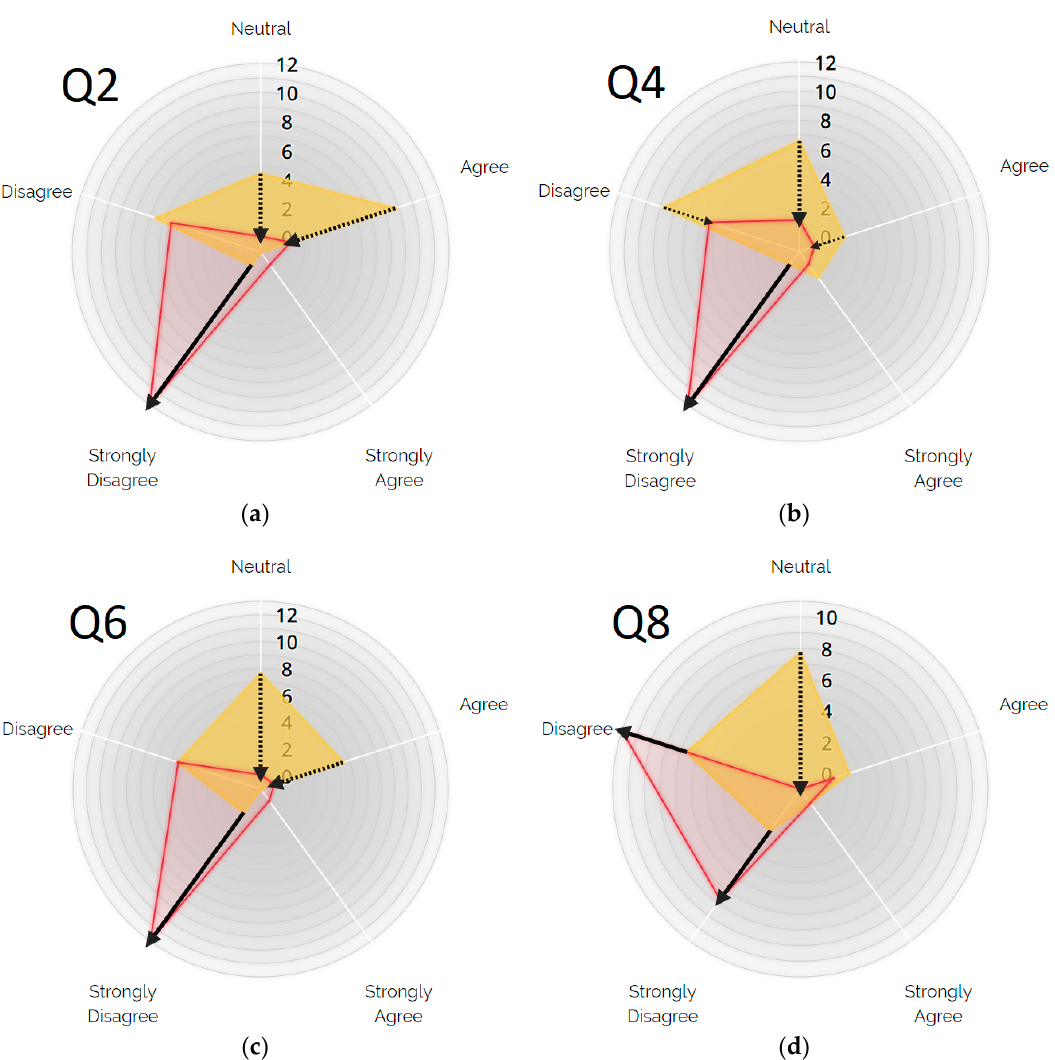
Figure 6. Radar charts showing for all participants, where the changes induced by the games for answers to hypothesis should reflect a stronger disagreement. Each participant answer ( − 2 = strongly disagree, − 1 = disagree, 0 = neutral, 1 = agree, 2 = strongly agree) is rated on one axis in yellow (pre-game) and red (post-game) areas. The questions answered are ( a ) Q2; ( b ) Q4; ( c ) Q6; ( d ) Q8.